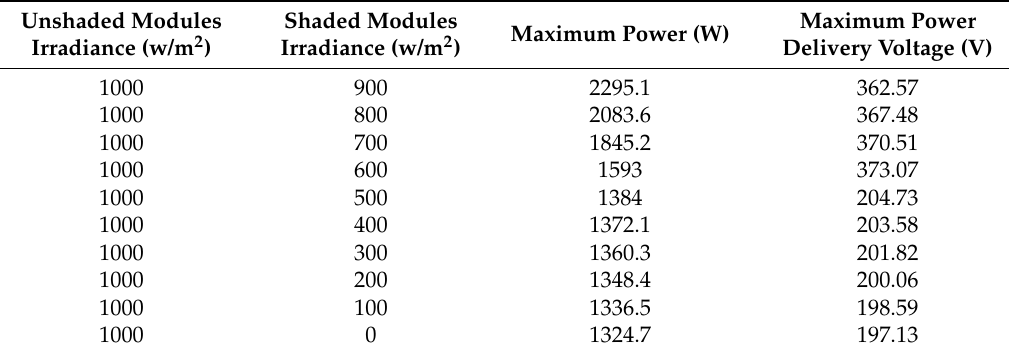
Table 7. Maximum powers of the 8 modules shaded setup.